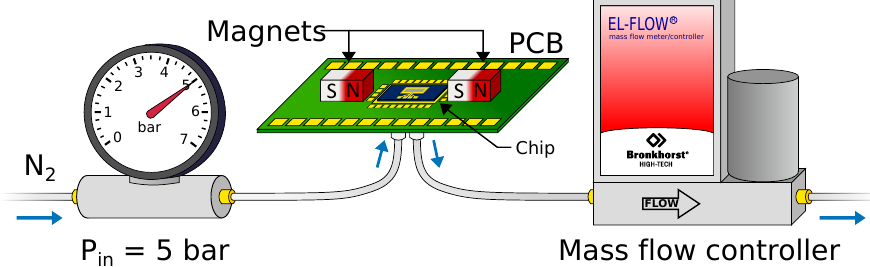
Figure 12. Fluidic measurement setup. Nitrogen gas is fed through the sensor chip at an input pressure P in = 5 bar (gauge pressure), while the mass flow is regulated using an external mass flow controller at the outlet. Figure adapted from